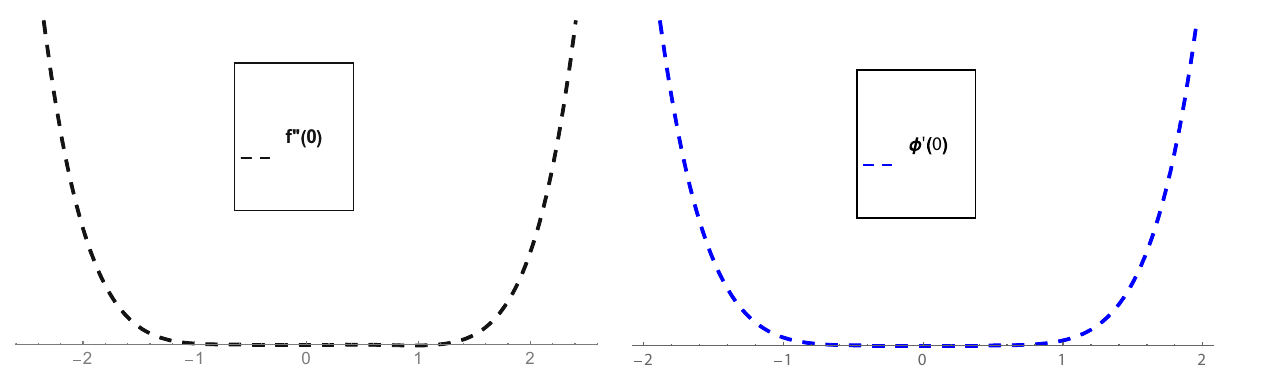
Figure 2: h Curve - for f ″ 0 ( ) . Figure 4: h Curve - for ϕ ′ 0 ( ) .